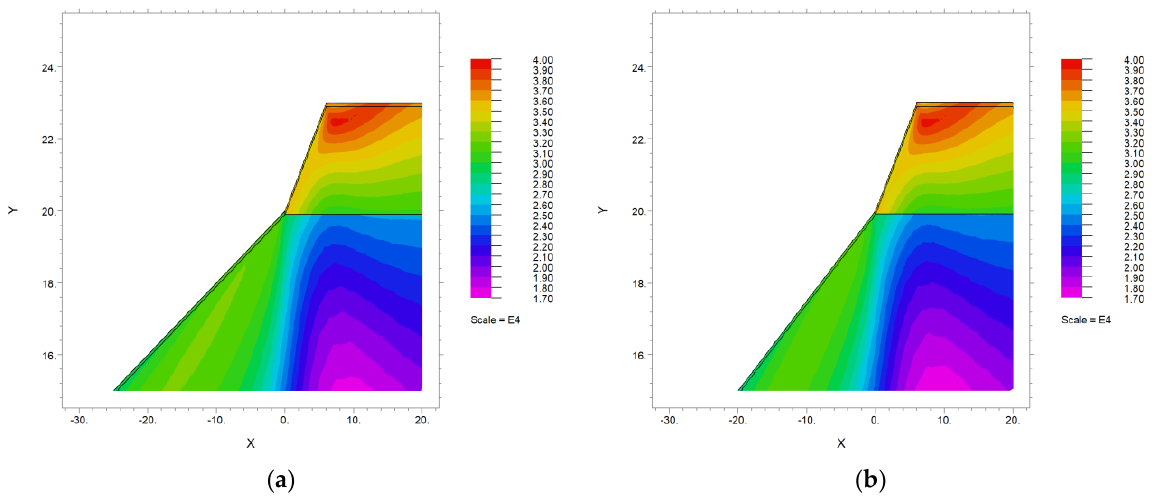
Figure 13. Shear stresses for the underwater slope inclination of 1:15 — ( a ) clay-type subsoil, ( b ) sand-type subsoil.